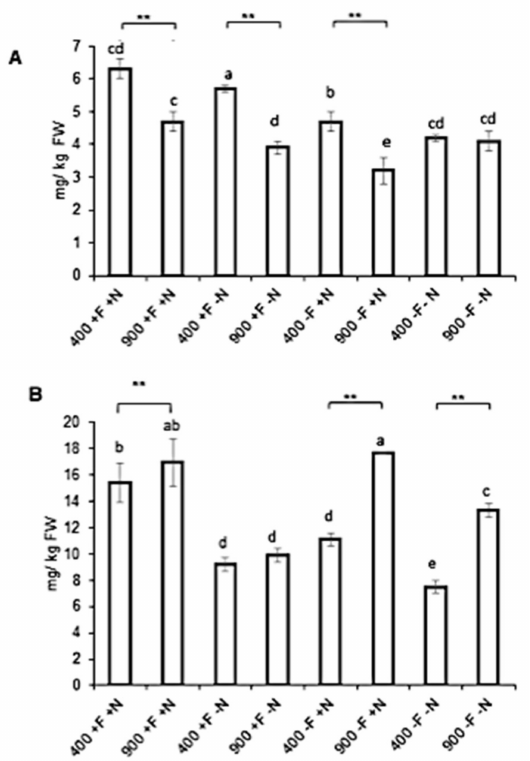
Figure 3. Carotenoids content of Micro-Tom tomato fruits. Fruits samples were collected from hydroponically grown plants under ambient (400 ppm) or elevated (900 ppm) atmospheric CO 2 concentrations with four nutritional regimes: control (+F/+N), iron deficiency ( − F/+N), nitrogen deficiency (+F/ − N) or dual deficiency ( − F/ − N). ( A ) Total carotenoids content, ( B ) Lycopene content. Error bars show ± SD ( n = 3). T -test significance: **, p < 0.01. Means within each condition with the same letter are not statistically different according to one-way ANOVA followed by post hoc Tukey test ( p <